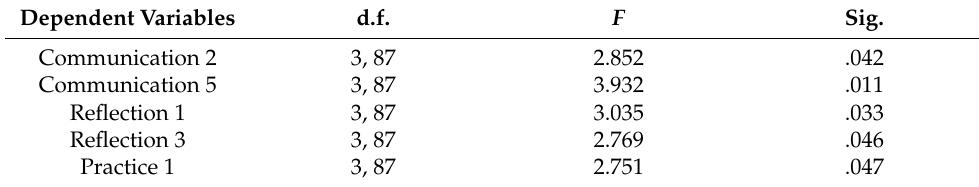
Table 4. Results of the One-Way